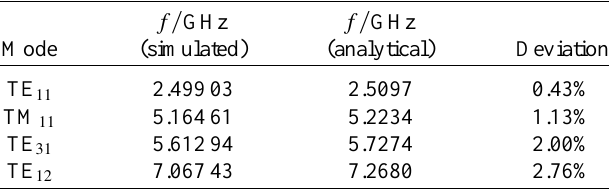
TABLE I. Computed [4] cutoff frequency of the dipole (and of the structure sextupole) modes in the end tubes (using only 1 4 making use of the symmetries). In the frequency range between 2.5 and 5 GHz the deviation between the analytical values and the computational model (fixed discretization with 7 3 7 grid points in the cross section of the beam tube) is below